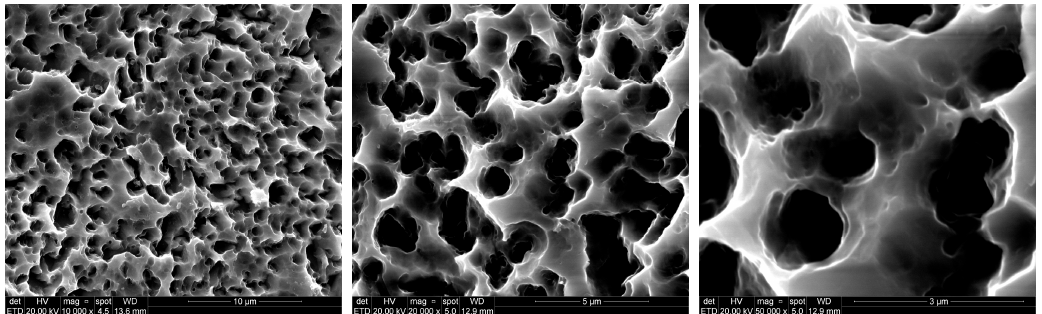
Figure 2. Images in different increase obtained by scanning electronic microscopy (SEM) of the surface of all sample groups.